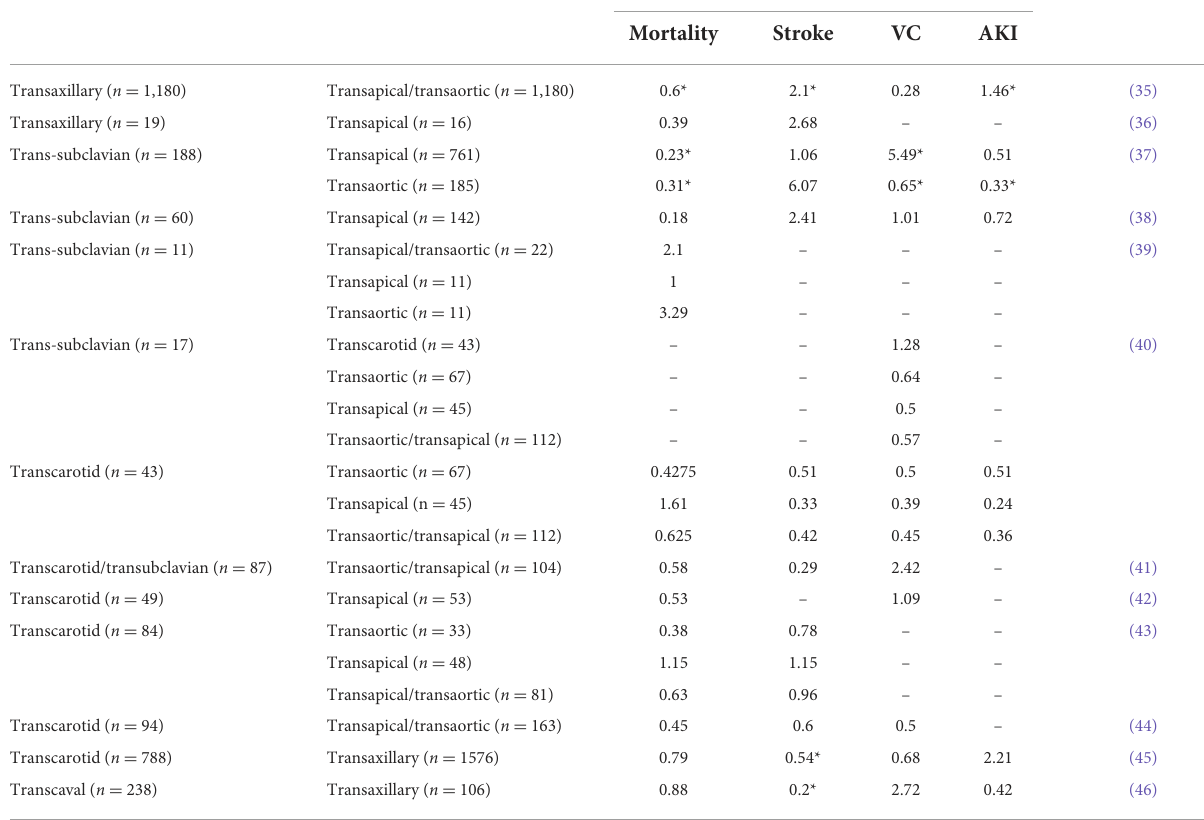
TABLE 2 Comparison between alternative vascular